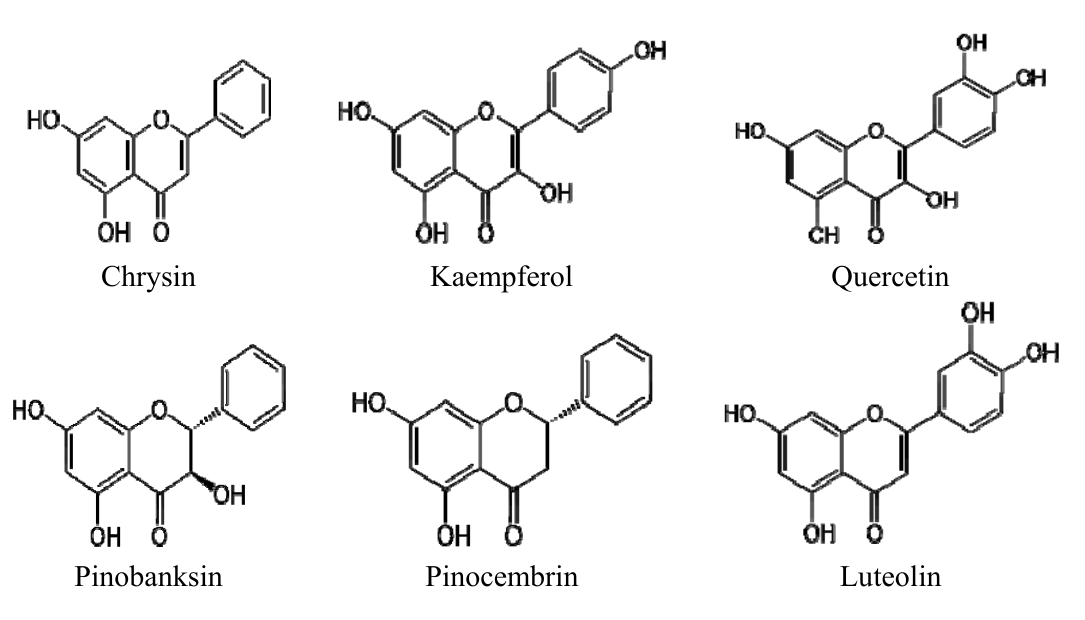
Figure 1. Chemical structures of flavonoids in